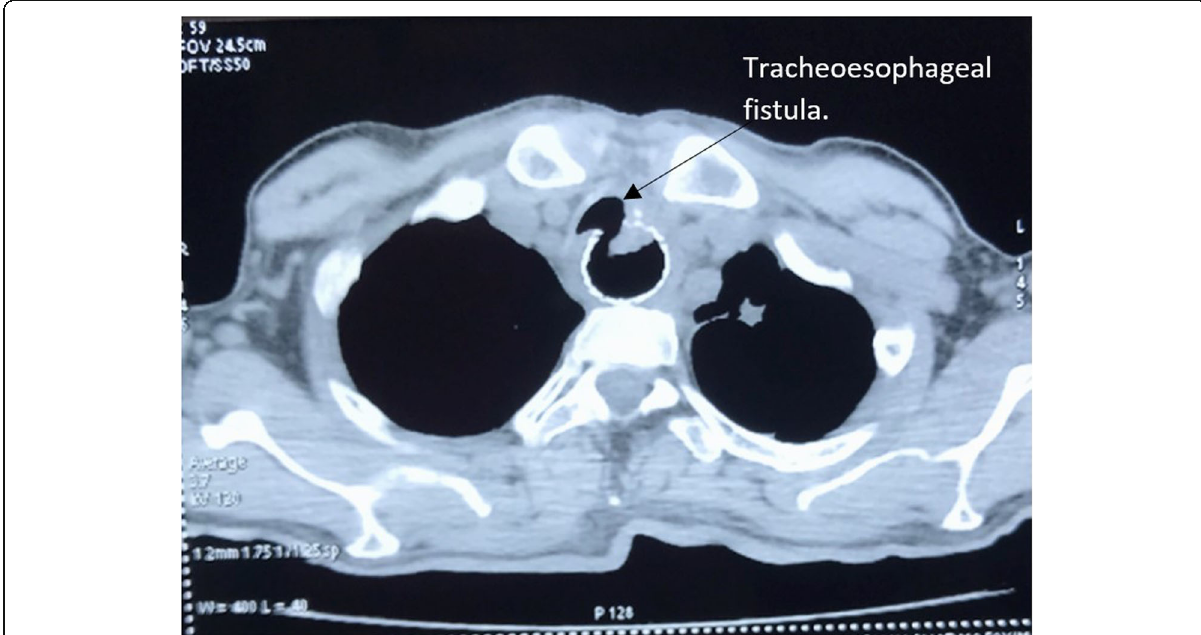
Fig. 1 CT chest showing tracheoesophageal fistula at the level of proximal margin of esophageal